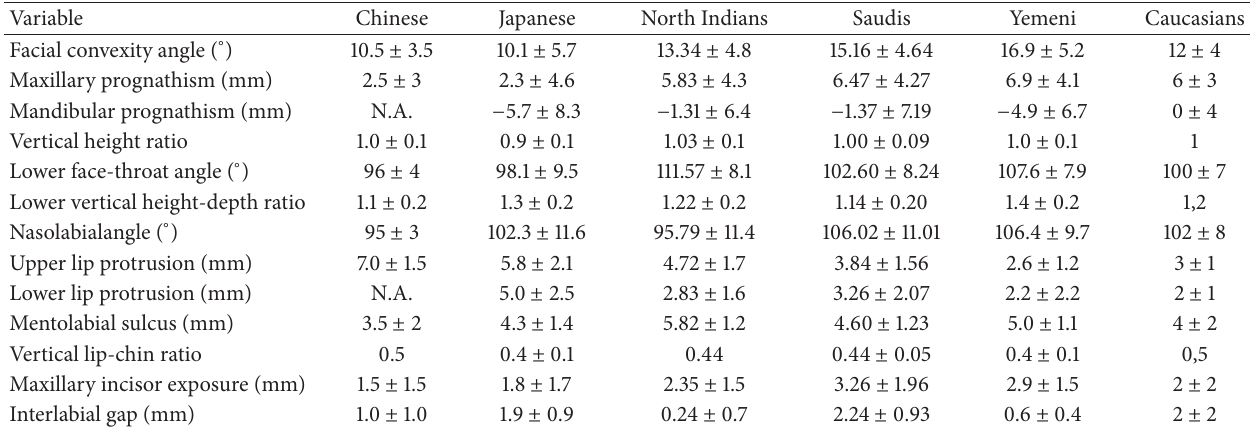
Table 3: Soft tissue cephalometric values of different ethnic groups using Legan and Burstone analysis. Variable Chinese Facial convexity angle ( ∘ ) Maxillary prognathism (mm) Mandibular prognathism (mm) Vertical height